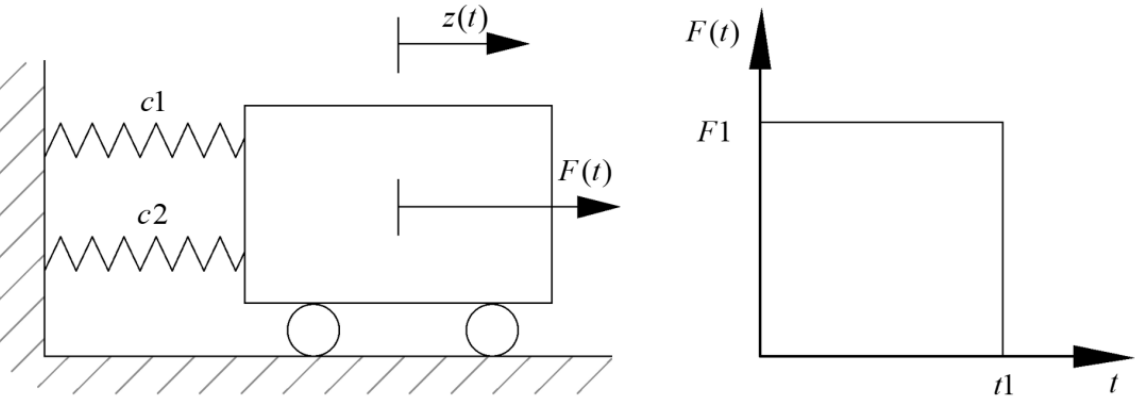
Figure 7. Dynamic response of a nonlinear oscillator. Table 3. The mean values and standard deviations for example